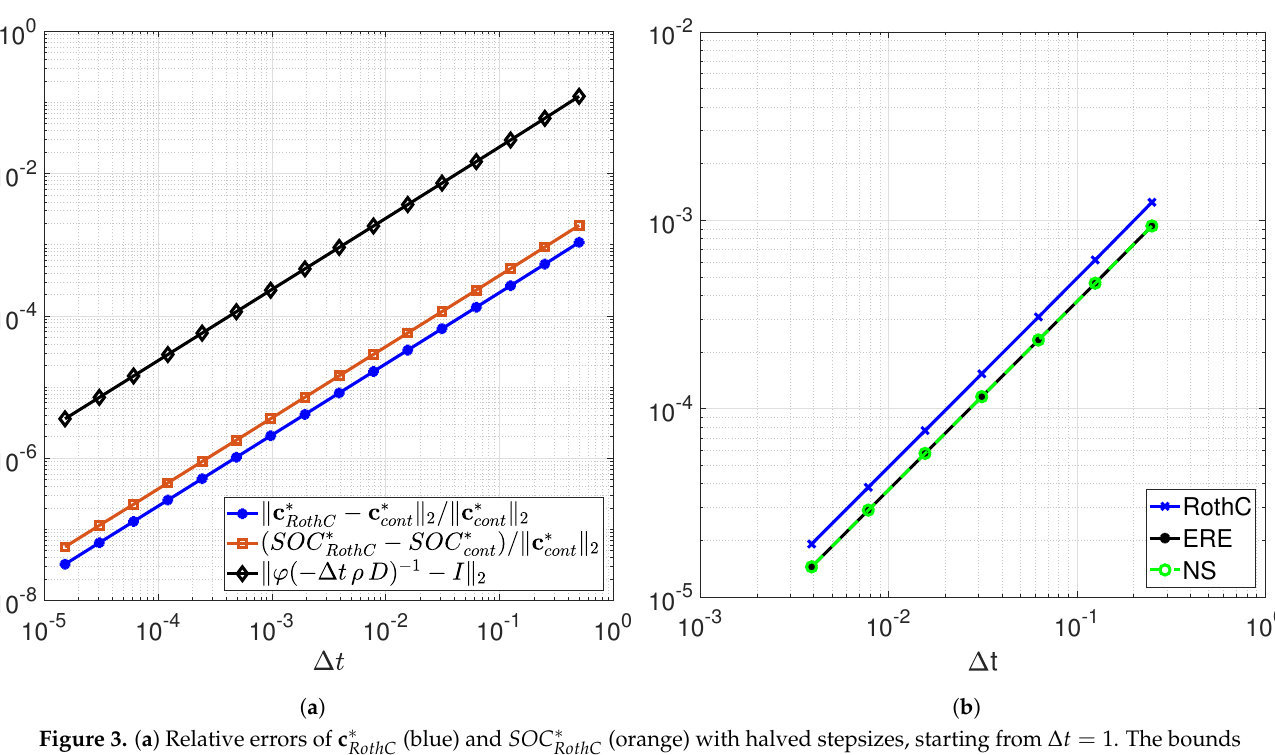
Figure 3. ( a ) Relative errors of c ∗ (blue) and SOC ∗ (orange) with halved stepsizes, starting from ∆ t = 1. The bounds RothC RothC on the relative error (cid:107) ϕ ( ∆ t ρ D ) − 1 − I (cid:107) 2 in (10) are also plotted in black. The estimated order of convergence is 1.0037 for the relative error on c ∗ and 1.0022 for the relative error on SOC. ( b ) The log-log plot of the norm two errors of the periodic RothC solutions of discrete RothC, Exponential Rosenbrock–Euler (ERE) and Non-Standard (NS) schemes, with respect to the reference solution obtained in the long run with the ode45 Matlab code, at ∆ t = 1/2 i , i = 2, . . . ,8. The estimated orders of convergence are 1.0042, 1.0017 and 1.0018 for the discrete RothC, ERE and NS schemes,